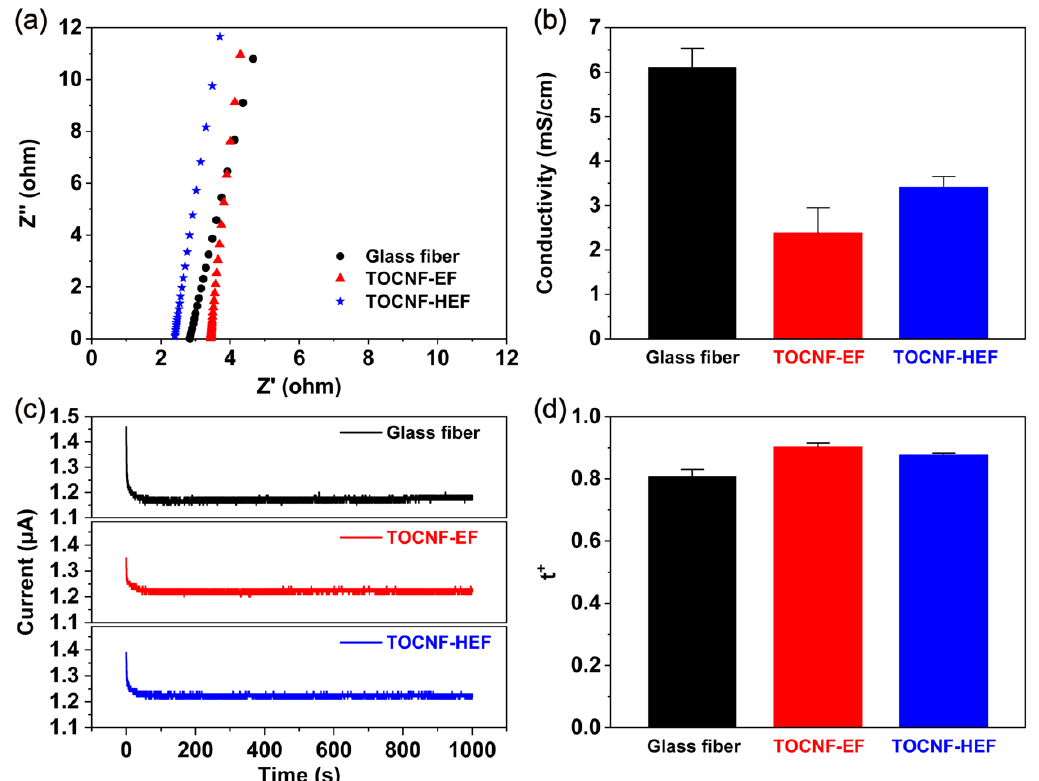
Figure 7. ( a ) The Nyquist plots of SS/separators/SS cells; ( b ) conductivity of glass fiber, TOCNF-EF and TOCNF-HEF; ( c ) amperometric i-t curves with a constant dc bias 10 mV; ( d ) Na + transference number (t + ) of glass fiber, TOCNF-EF and TOCNF-HEF. The above tests were conducted at room temperature.